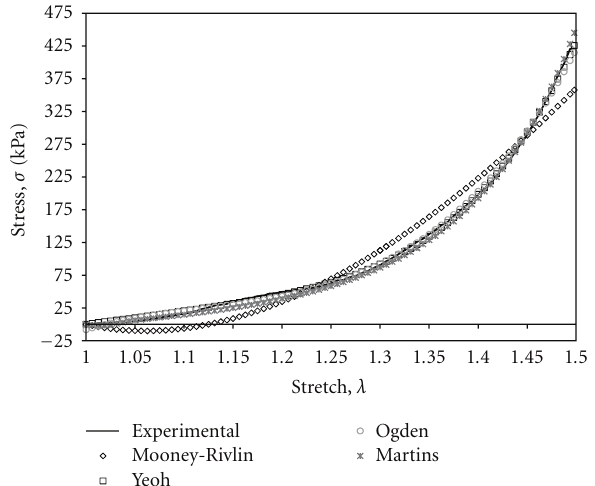
Figure 4: Experimental data plotted against curve fits to nonlinear material models.